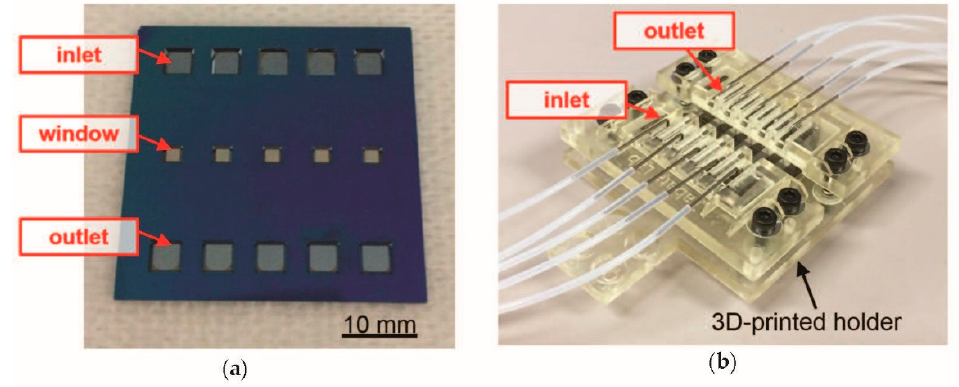
Figure 3. Optical image of the fabricated microfluidic device ( a ) and the assembled system using a 3D-printed polymer holder ( b